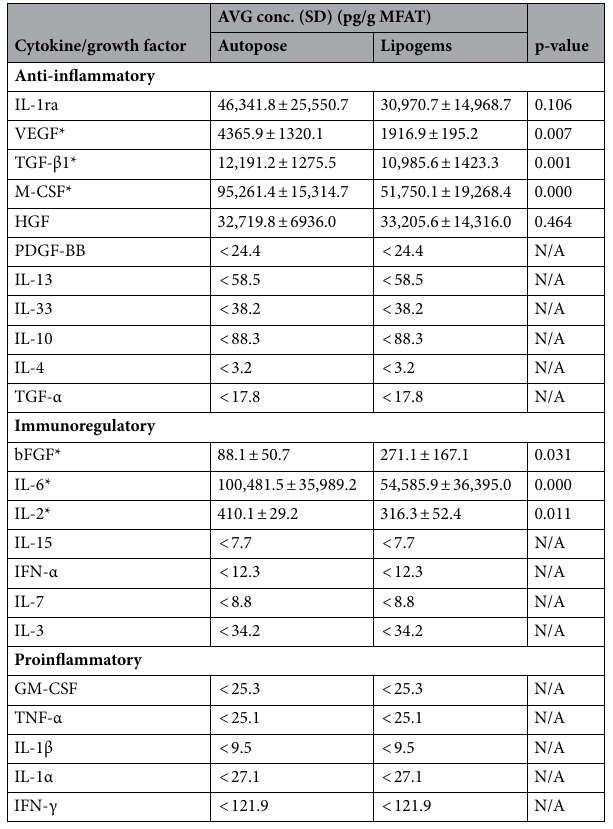
Table 5. Growth factor and cytokine content in the cell culture supernatant after 7 days. Aggregate mean and standard deviation (SD) of data represented as “mean ± SD”. When concentrations were below detectable limits, less than the limit of detection is shown and statistical analyses was not performed, indicated by “N/A”. *Represents statistically significant difference between MFAT